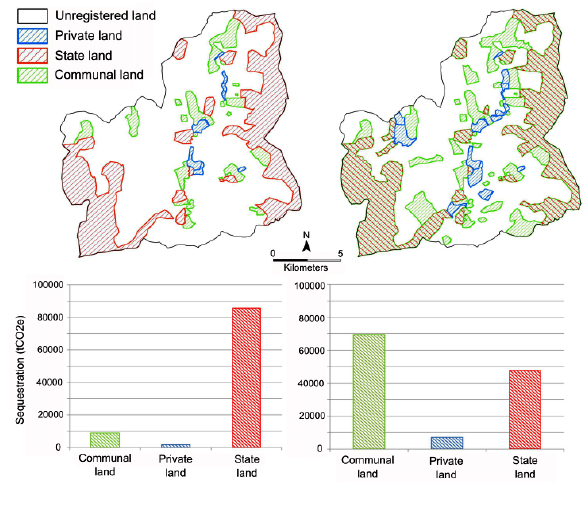
Fig. 5. Representation of the tenure systems generated by different management strategies for the village cluster